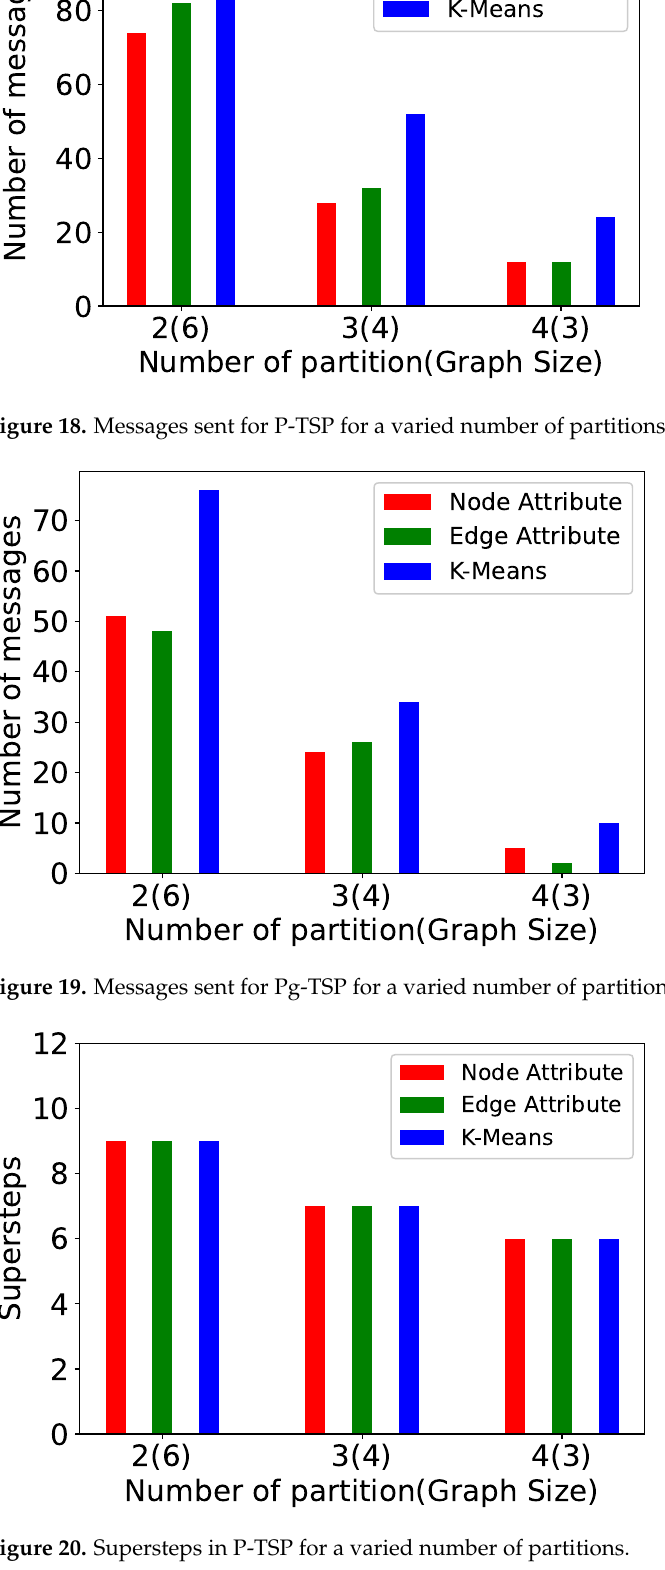
Figure 20. Supersteps in P-TSP for a varied number of